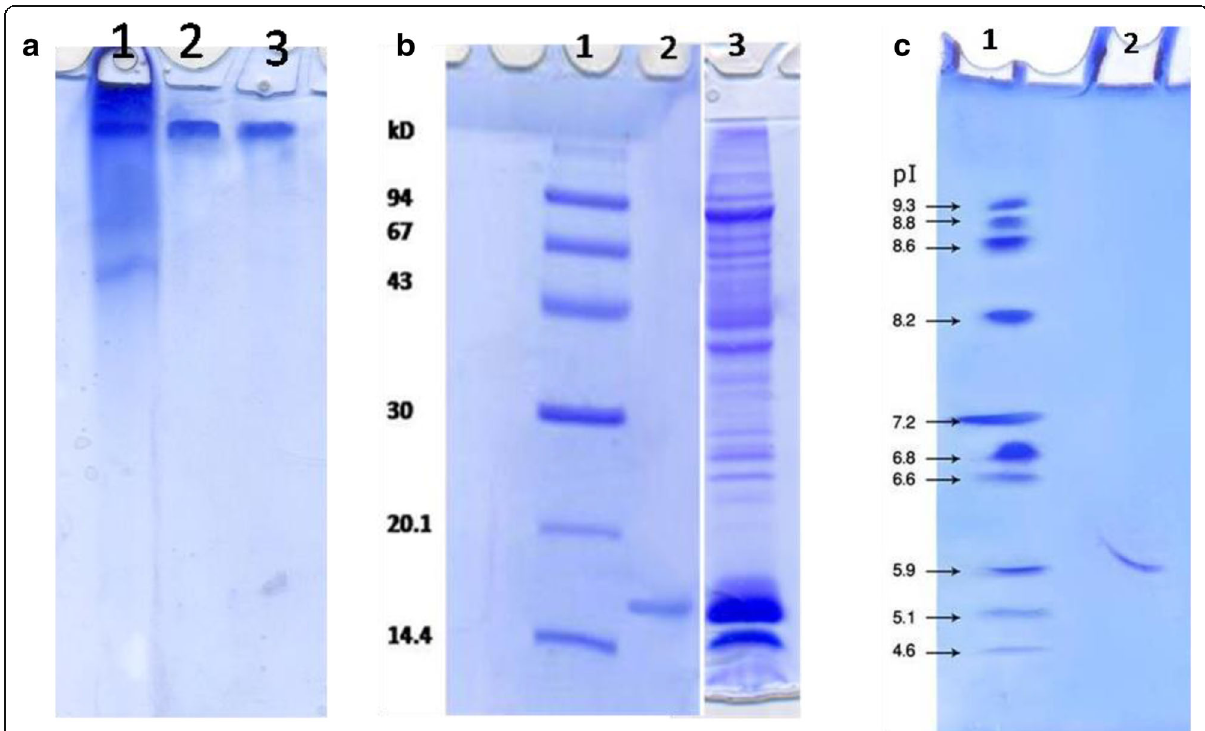
Fig. 2 a Electrophoretic analysis of bee venom PLA2 different purification steps on 7% native PAGE: (1) crude bee venom, (2) DEAE-cellulose fraction, and (3) Sephacryl S-300 PLA2 fraction. b Bee venom PL A2 subunit on 12% SDS-PAGE: (1) molecular weight markers, (2) bee venom purified PLA2, and (3) crude bee venom. c Isoelectrofocusing: (1) isoelectric point ( p I) marker proteins and (2) purified